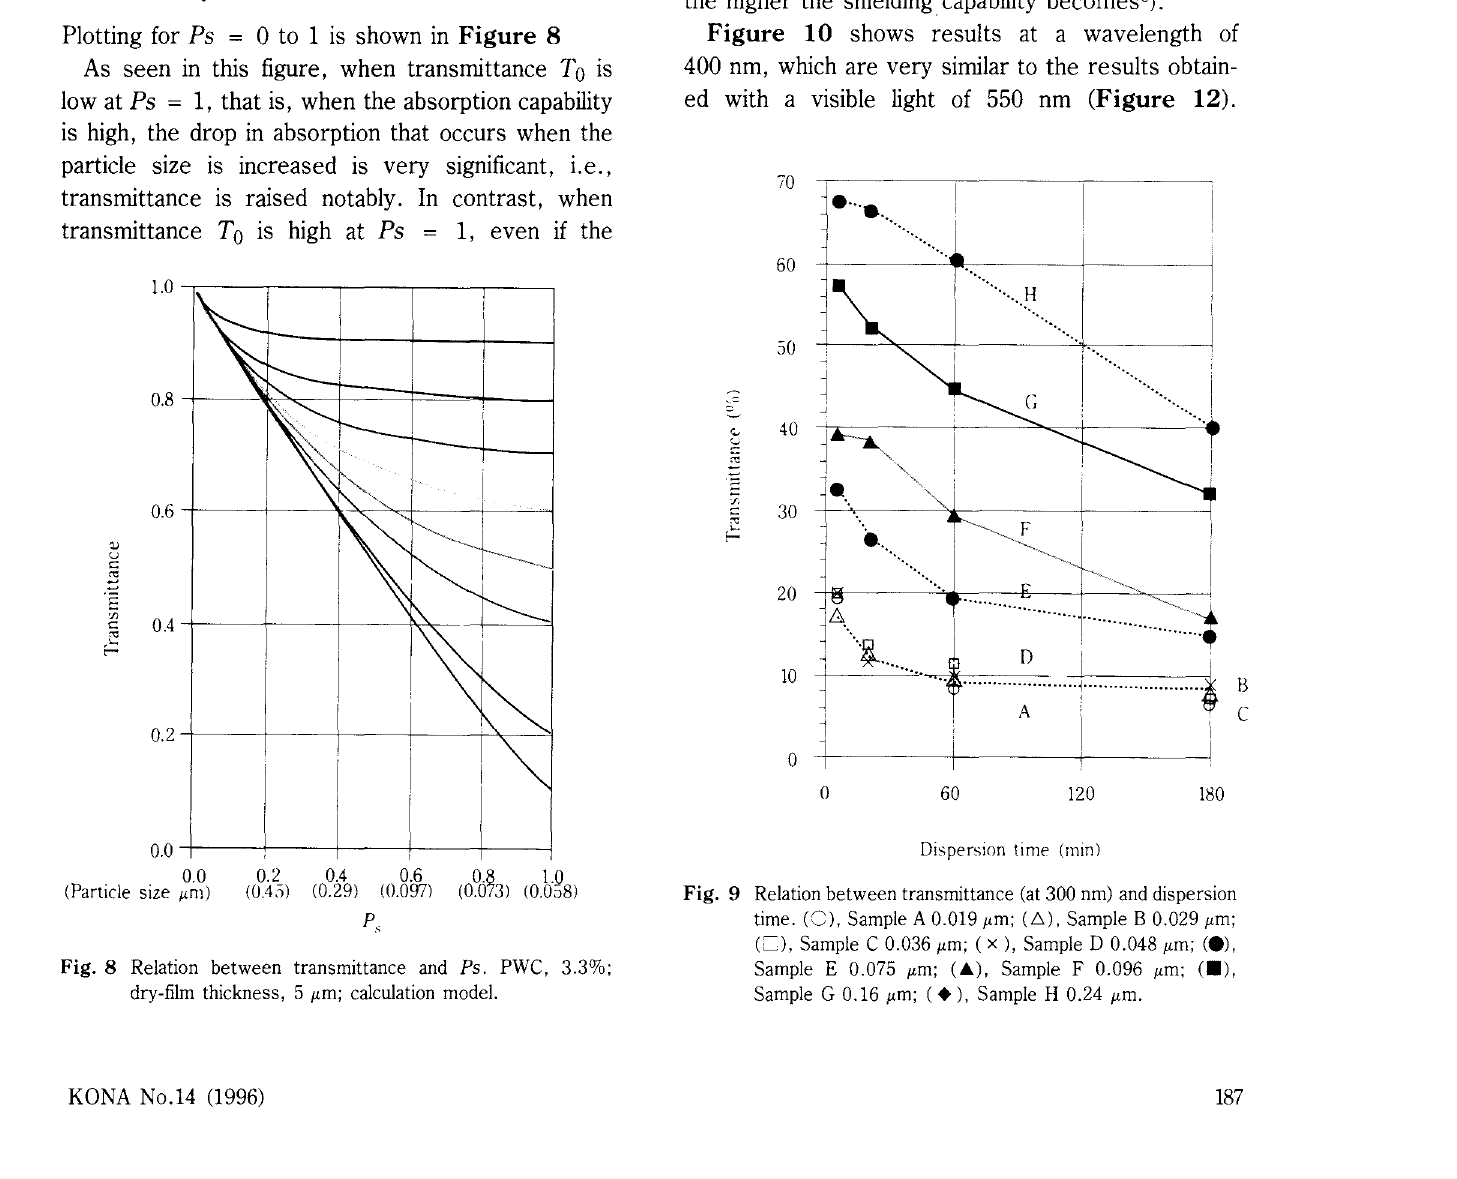
Fig. 8 Relation between transmittance and Ps. PWC, 3.3%; dry-film thickness, 5 I'm; calculation model.